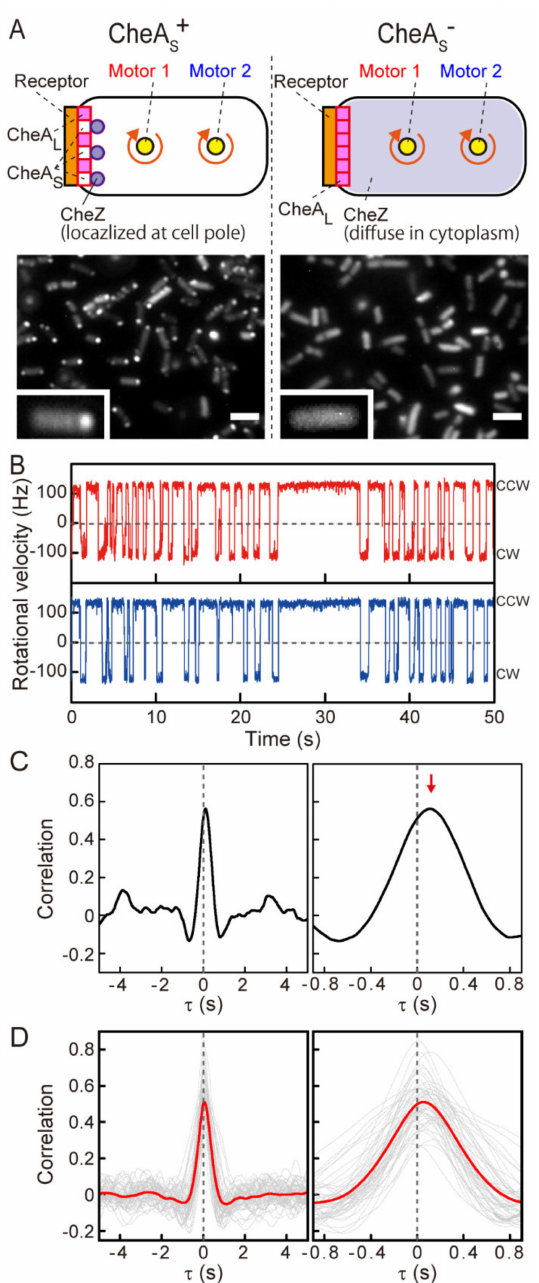
Figure 2. Coordination of steady-state switching of flagellar motors on a CheA S − cell. ( A ) Localization of CheZ-EGFP in a CheA S + cell (left) and a CheA S − cell (right). A magnified image of each strain is shown at the bottom. Bar = 3 µ m. ( B ) The time traces of the rotational directions of the proximal motor 1 (red) and the distal motor 2 (blue) on a CheA S − cell. ( C ) A cross-correlation profile of the time traces of motors 1 and 2, which are depicted in ( B ) (left) and magnified (right). The analysis was based on proximal motor 1. The red arrow indicates the time of peak correlation ( ∆ τ correlation = + 0.110 s). ( D ) Gray lines indicate a correlation analysis for CheA S − cells measured at 1250 fps. The traces of 45 cells that showed coordination of switching are shown. The analysis was performed on the cells with monopolar or bipolar localization of GFP-CheW. The average of the ∆ τ correlation was 68 ± 73 ms (mean ± SD). In a monopolar cell, the correlation was calculated based on the motor closer to receptor array. In a bipolar cell, the correlation was calculated based on the motor closer to more brighter receptor array. The red line shows the average traces of the correlation analyses from 45